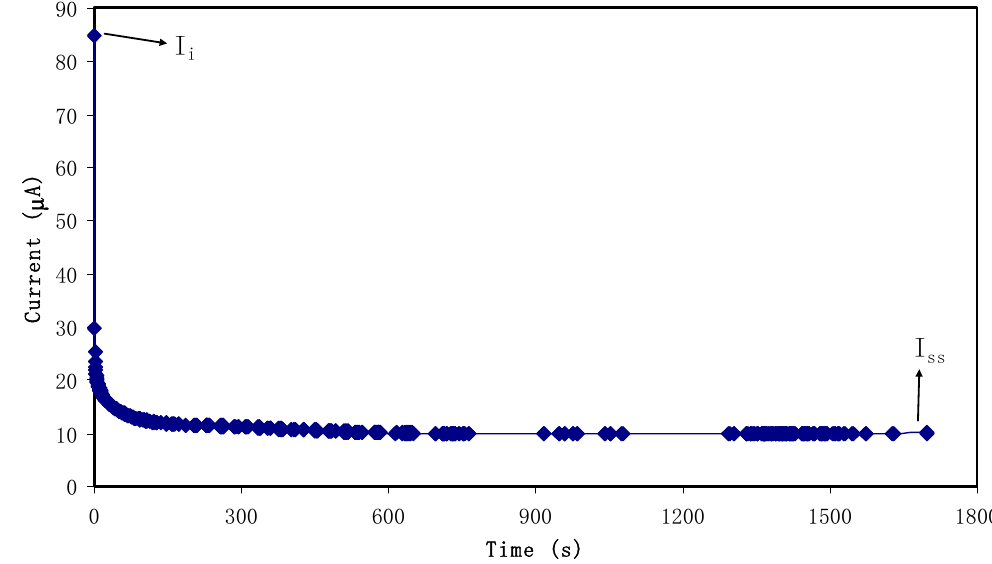
Figure 6. Polarization current versus time for the highest conducting (CSDX4) electrolyte film.